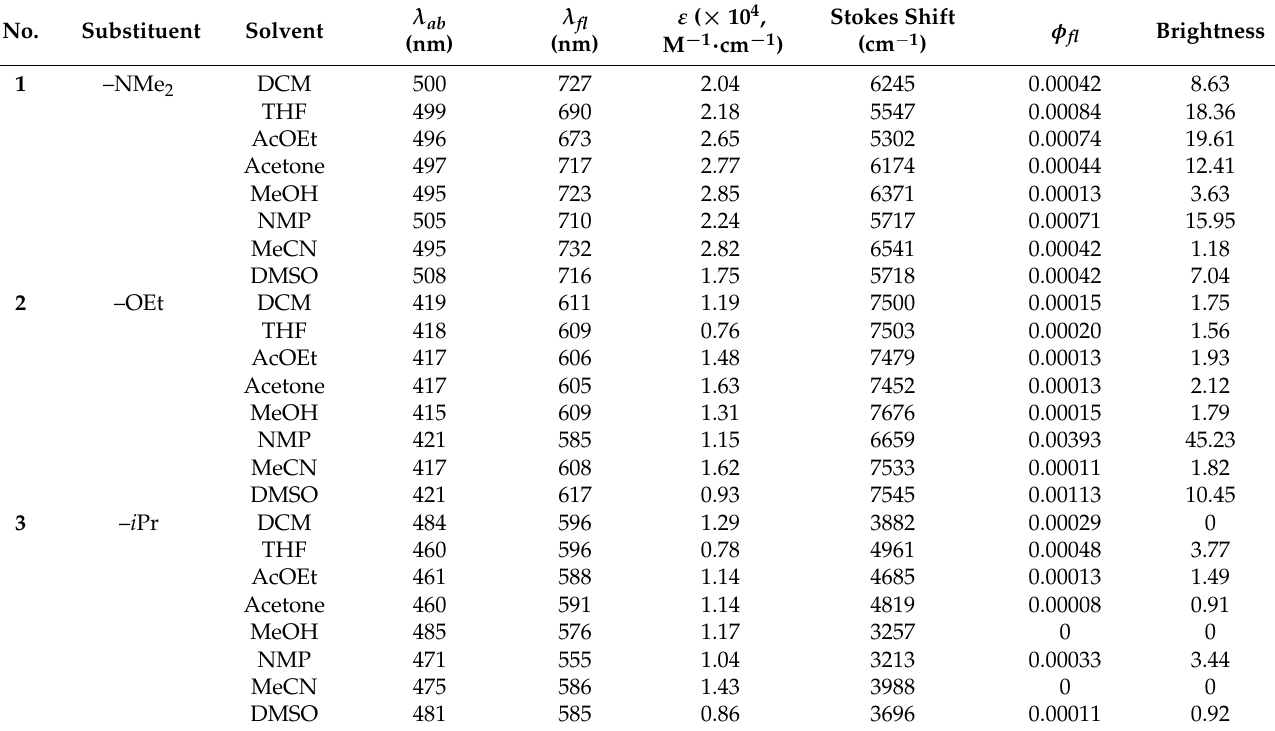
Table 1. Photophysical properties of compounds 1 – 4